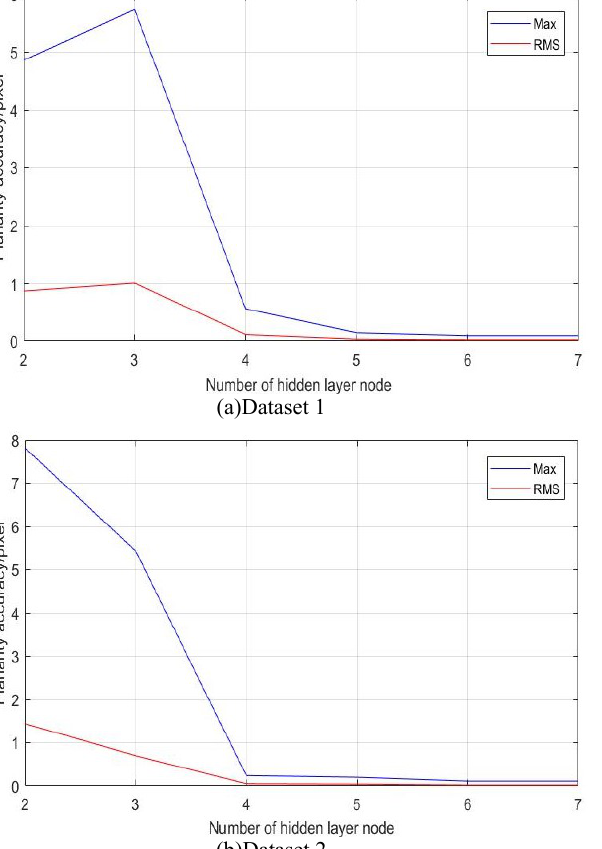
similar with the terrain-independent experiments, acoording to Figure 3. For both the terrain-independent and the terrain- dependent method, 7 nodes in the hidden layer may be a good